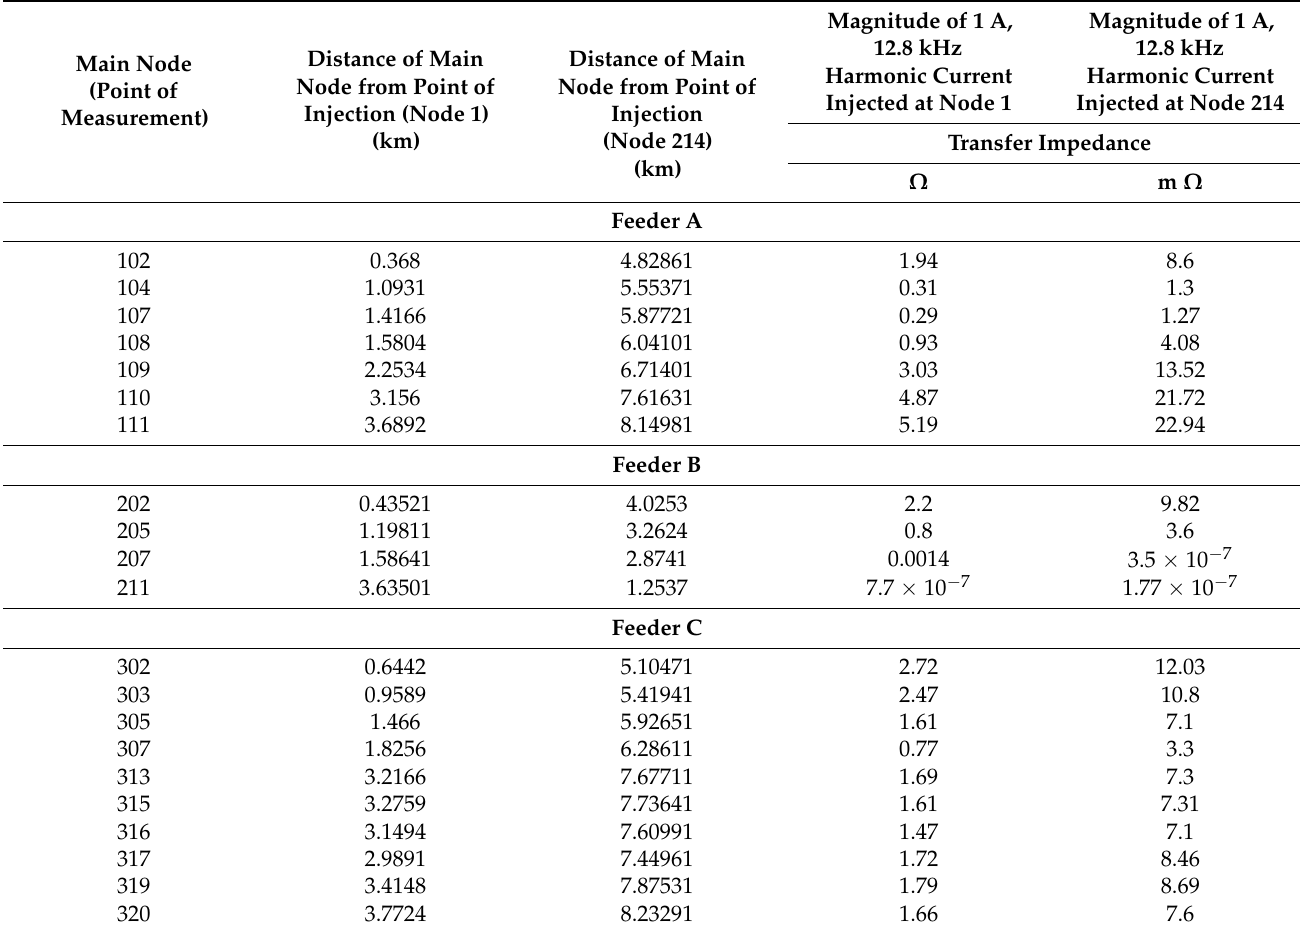
Figure 5. Frequency response with load. Table 4. Magnitude of transfer impedance obtained using FFT